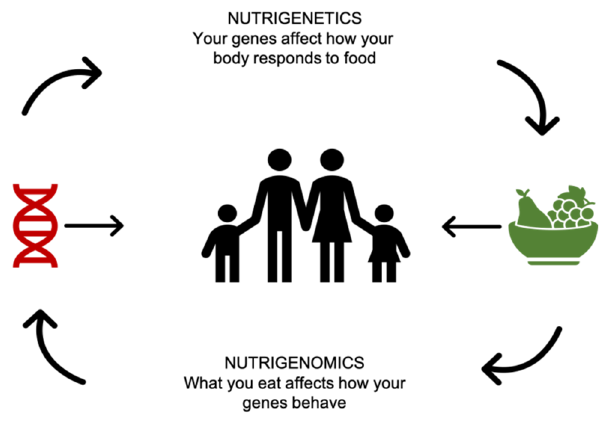
Figure 1. Nutrigenetics vs. nutrigenomics.